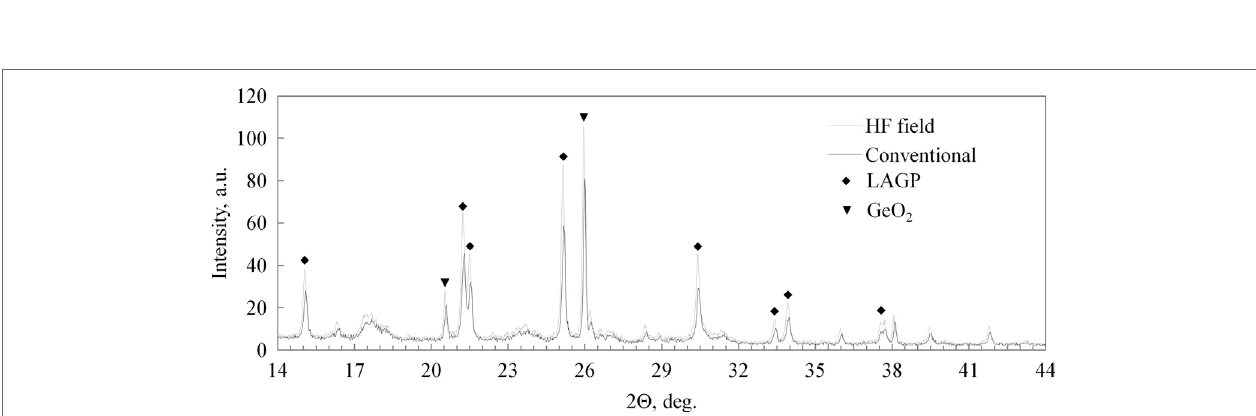
FigUre 4 | conventional vs. hF sintering displacement curves . Note that 100- μ m displacement corresponds to 10%